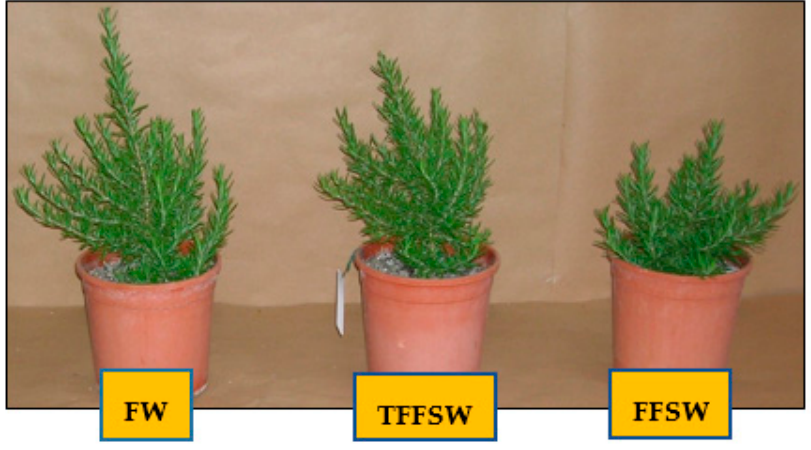
Figure 8. A view of the e ff ect of source of irrigation water on morphological and aesthetic parameters of rosemary plants.